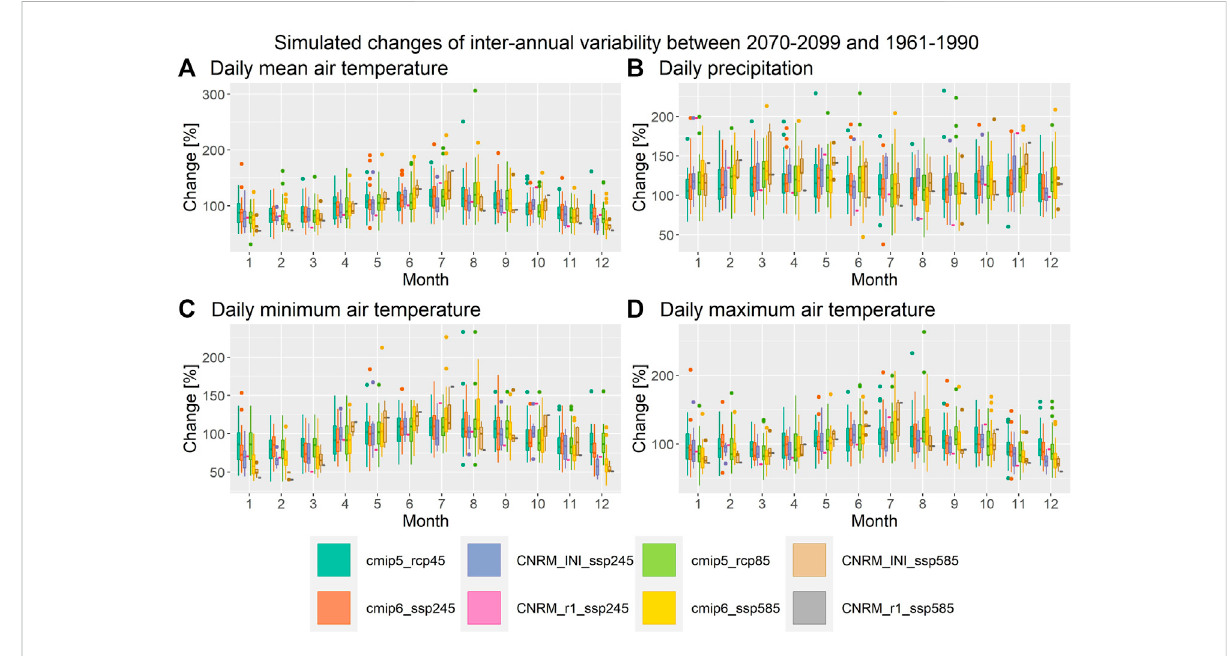
FIGURE 5 Same as Figure 4, but for relative changes in standard deviation of studied